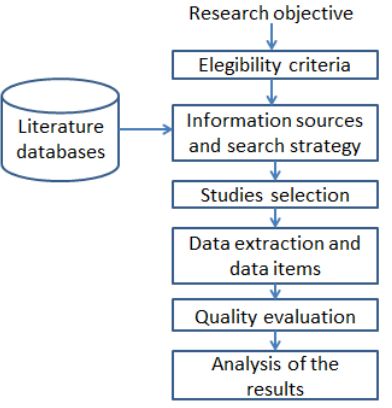
Figure 2. Search process for supporting the systematic literature